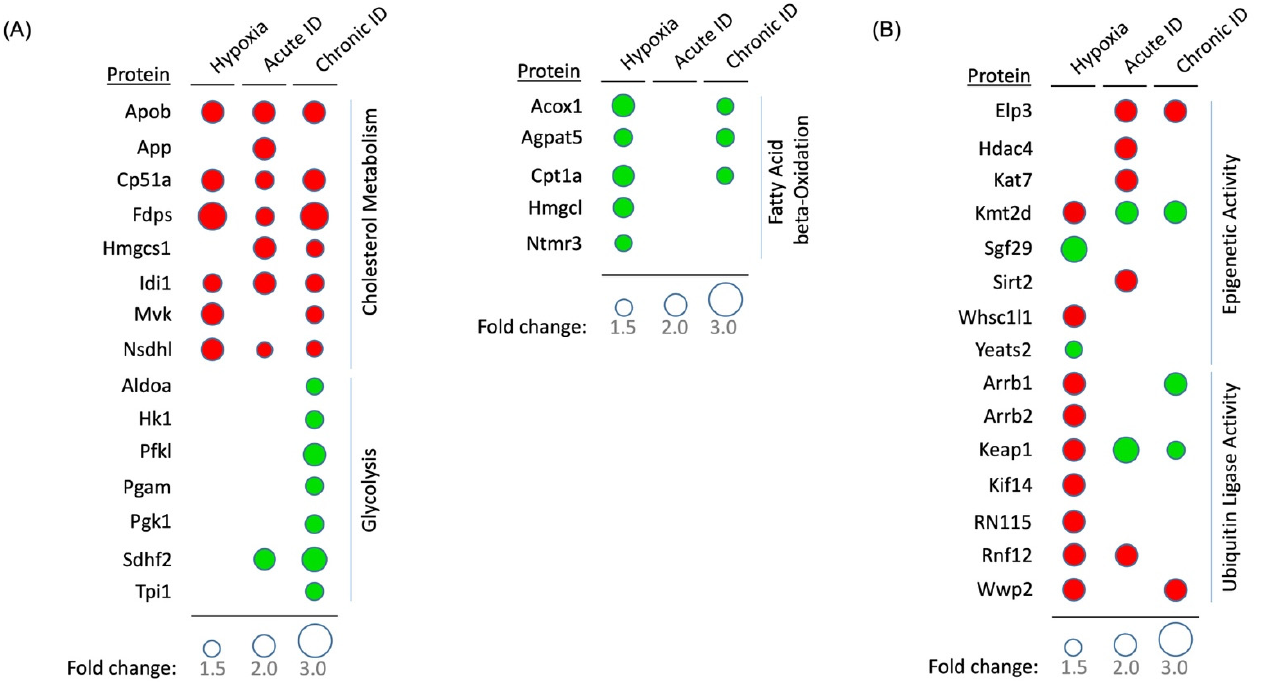
Figure 3. Representative protein abundance altered by hypoxia and iron deficiency. ( A ) Bubble heat map showing proteins having metabolic activity significantly changed under all treatments. Bubble size indicates level of fold change in protein quantitation with SILAC ratio <0.66 (green) and >1.5 (red). ( B ) Bubble heat map showing proteins having epigenetic and ubiquitination activity significantly changed under all treatments. Bubble size indicates level of fold change in phosphorylation site with SILAC ratio <0.66 (green) and >1.5